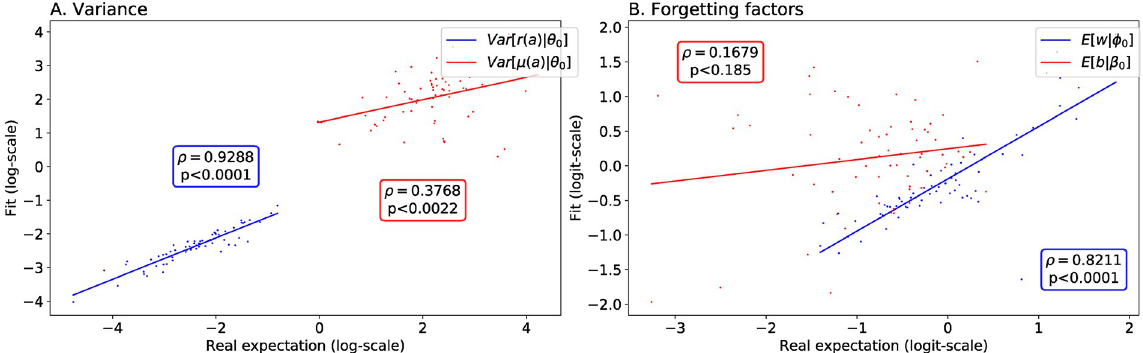
Fig 10. Correlation between true and expected values of the variances and forgetting factors. All the fitted values (y axis) are derived from the expected value of θ 0 ( A ., variance) and { ϕ 0 , β 0 } ( B ., forgetting factors) under the fitted approximate posterior distribution. Each dot represents a different subject. A . True (x-axis) to fit (y axis) correlation for the reward (blue) and mean reward (red) variance. Both expected values correlated well with their generative parameter, although the initial number of observations of the gamma prior α 0 did not correlate well with its generative parameter. B . True (x-axis) to fit (y axis) correlation for the first (blue) and second (red) level expected forgetting factor.